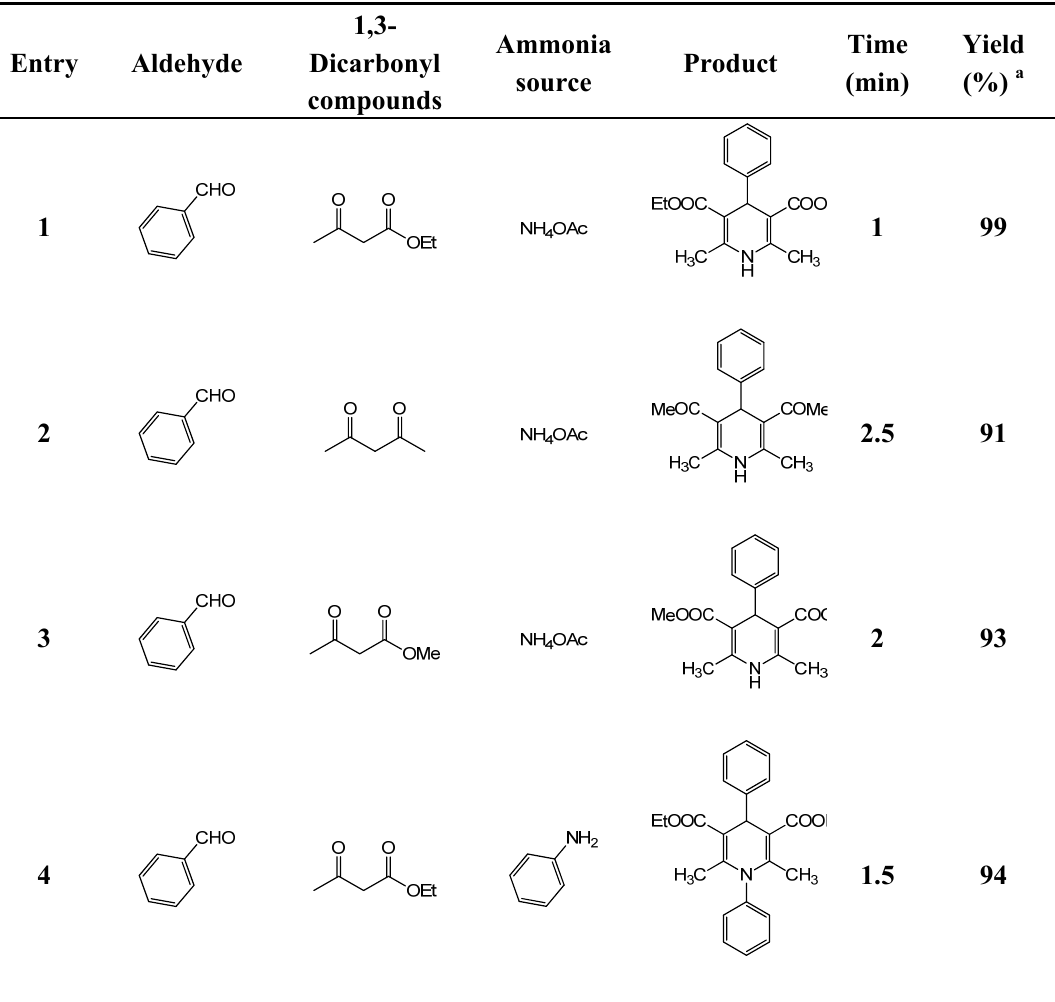
Table 4. Microwave-assisted one-pot, three component synthesis of 1,4-dihydropyridines using bismuth nitrate as catalyst (5 mol%) under solventless condition following Scheme